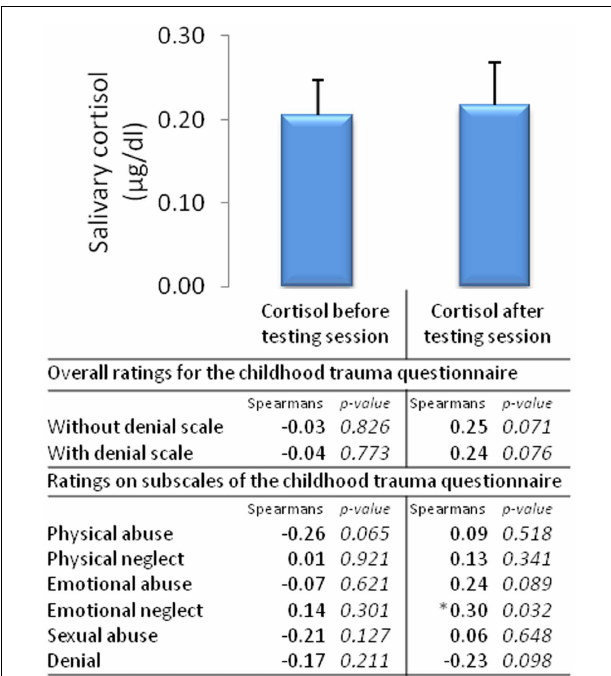
FIGURE 6 | Salivary cortisol before and after the testing session and correlates of overall ratings and ratings on subscales of the Childhood Trauma Questionnaire ( n = 53, mean ±